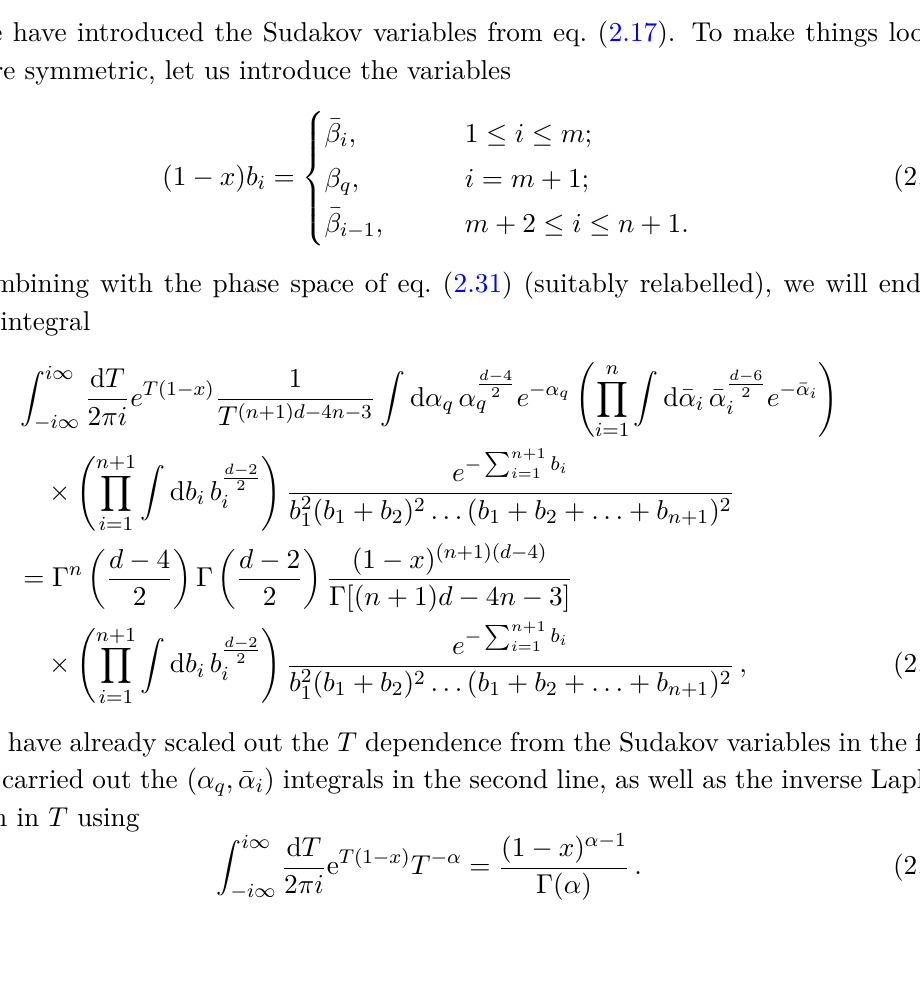
Figure 4. (a) Ladder graph contributing to T ( n ) , where all possible values of m must be considered; φ,q (b) similar but for T ( n ) 2 ,g